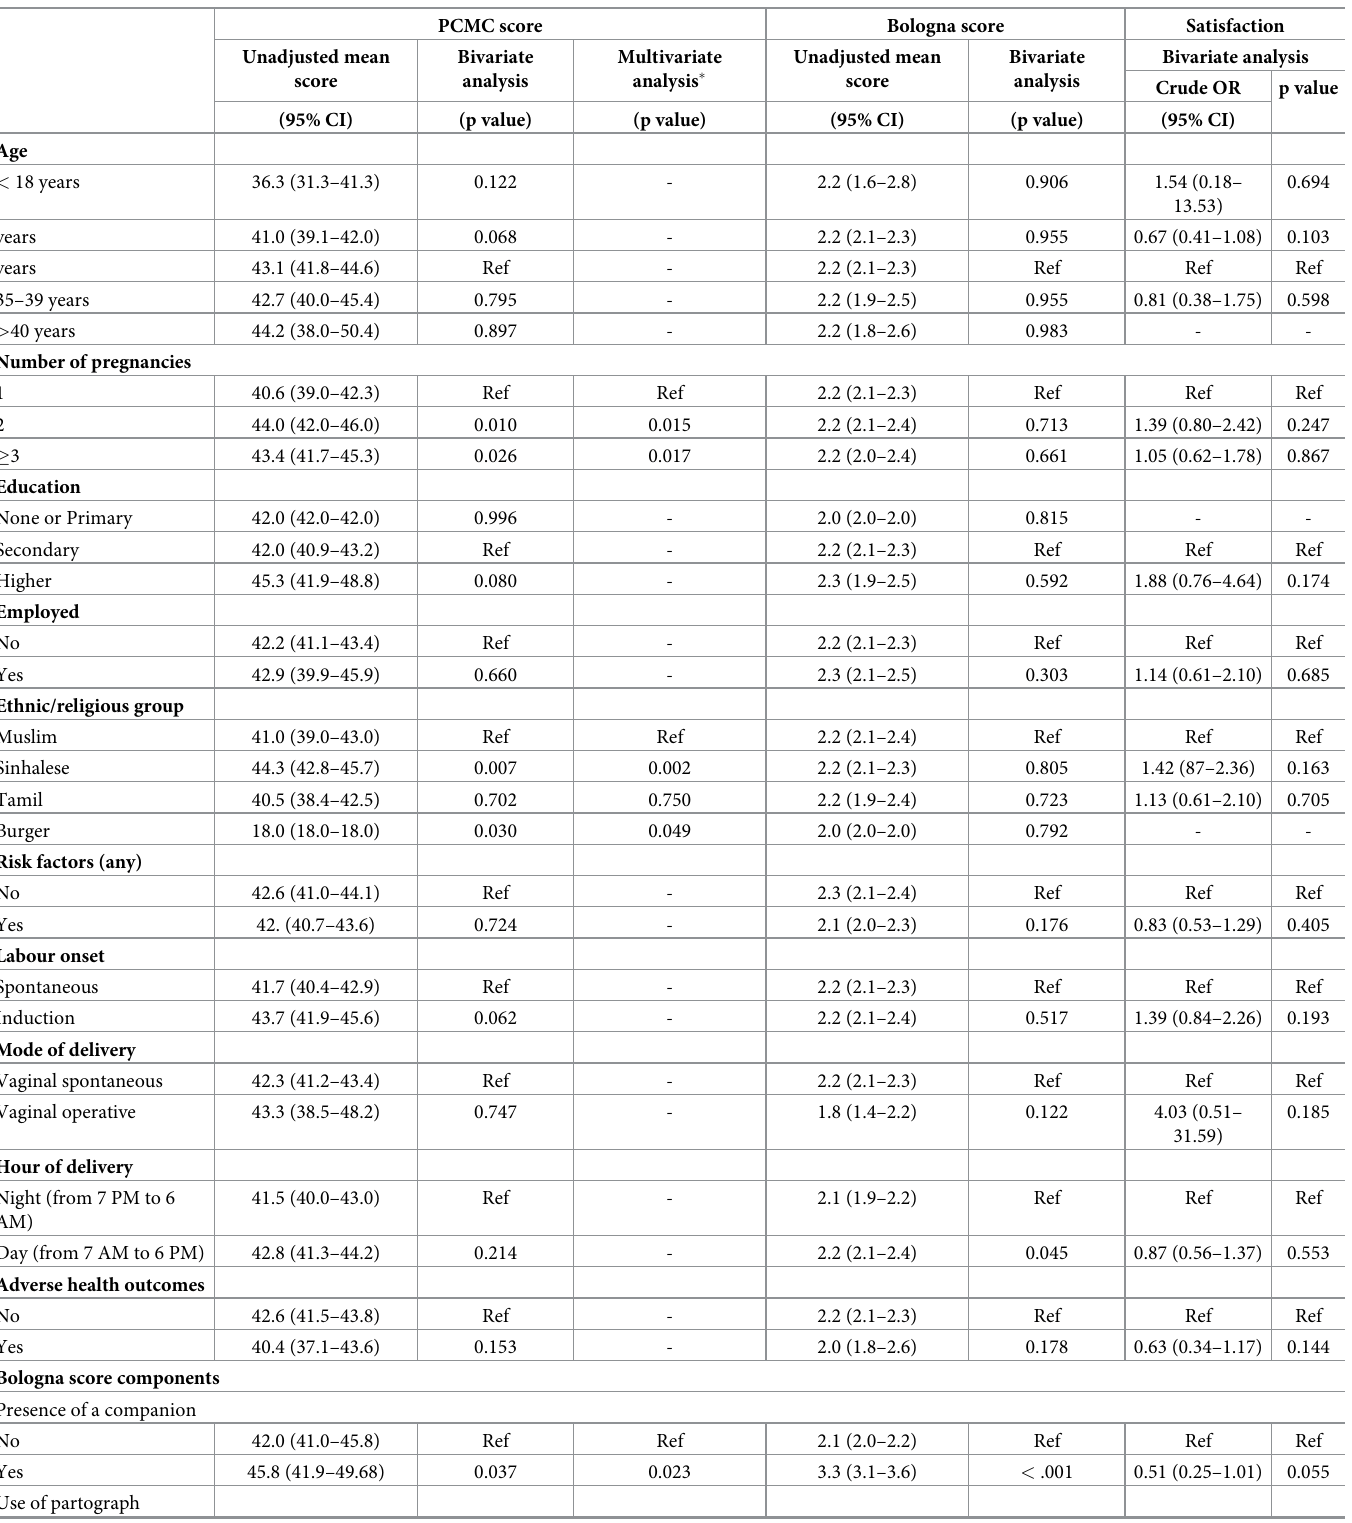
Table 3. Two- and multi-ways ANOVA. PCMC score Bologna